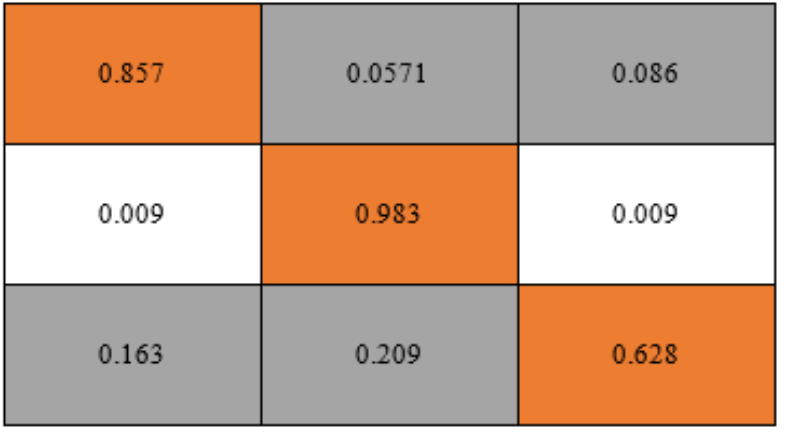
Figure 5. Normalised confusion matrix of multinomial classification.